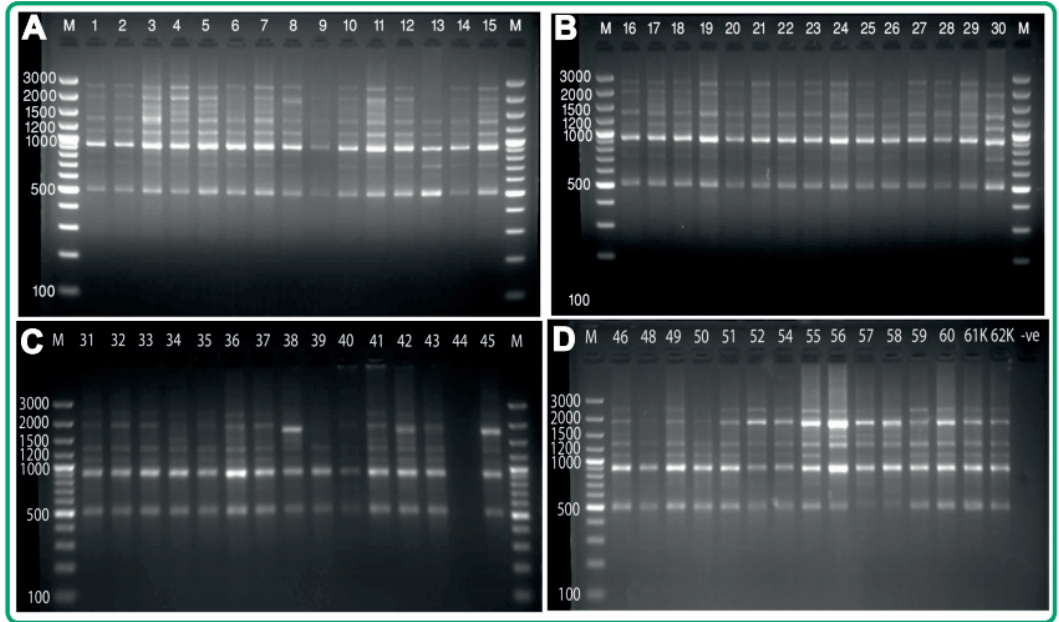
Figure 2. Inter-simple sequence repeat (ISSR) profile generated by the primer (C8). Lanes marked with M is 100 bp plus molecular weight markers. ( A ) Lanes 1–15 represent acid lime samples 1–15; ( B ) lanes 16–30 represent Acid lime samples 16–30; ( C ) lanes 31–45 represent acid lime samples 31–45; ( D ) lanes 46–62K represent acid lime samples 46–62K.